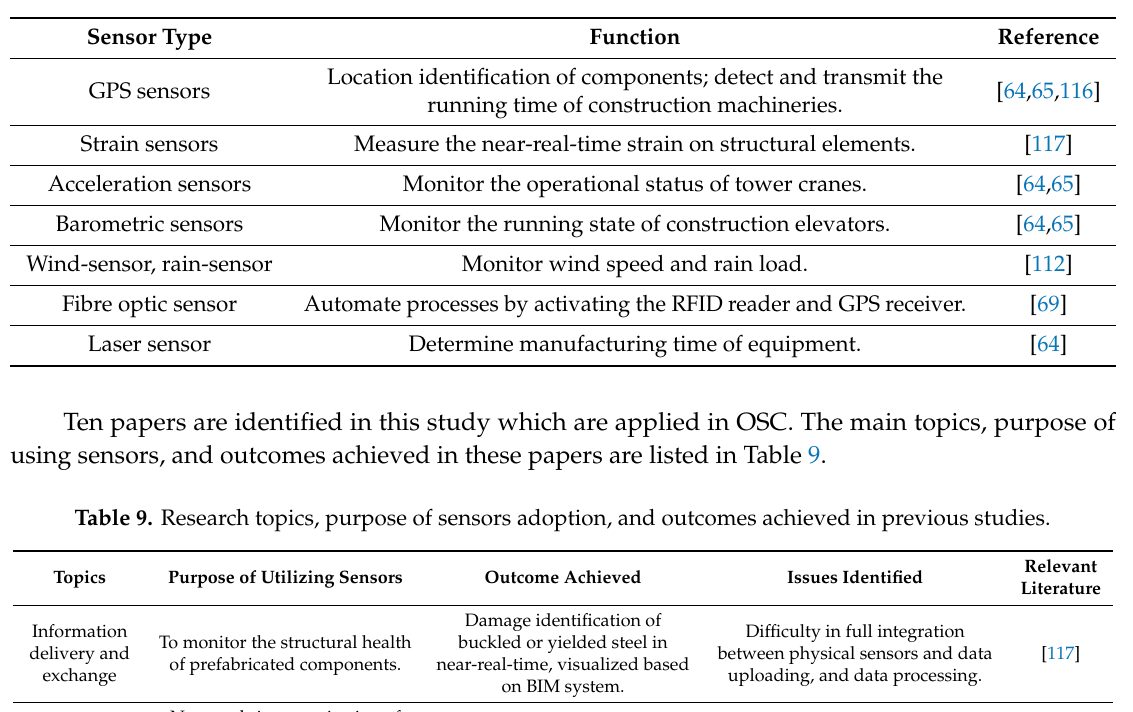
Table 8. Type of sensors.